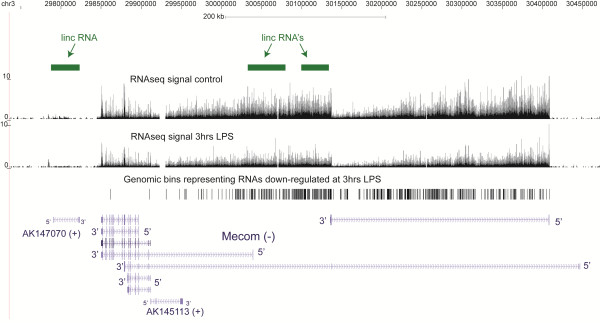
Examples of lincRNA regions originally found in intergenic regions [[33]] that are actually part of longer intronic transcripts.